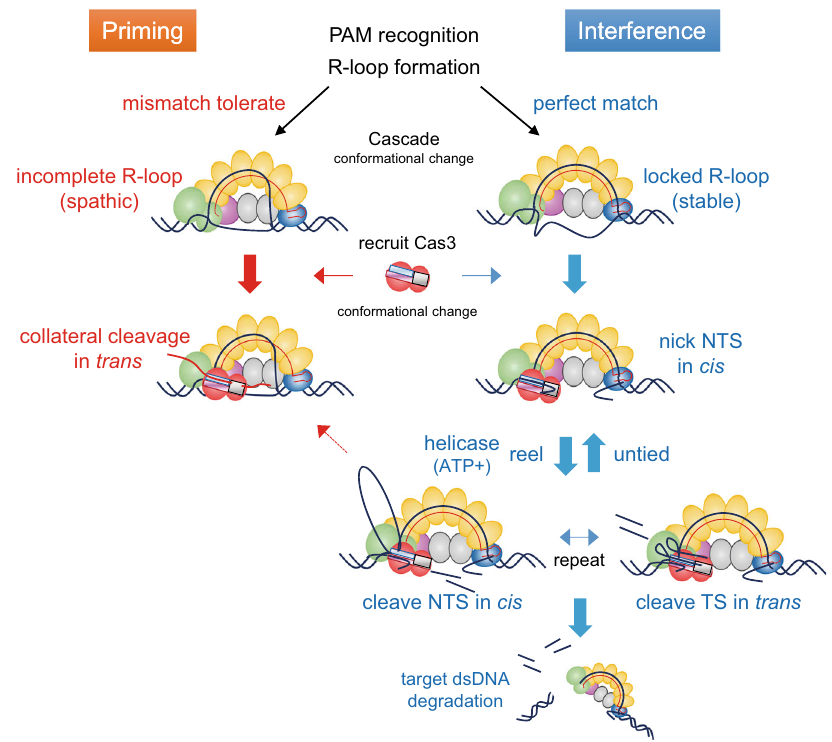
Fig. 6 | Mechanism of type I CRISPRinterference and priming. Cascade binding to target DNA with tolerated mismatches elicits collateral ssDNA cleavage as a priming mode. Stable Cascade binding via a complete R-loop formation drives nicking of the non-targetstrand (NTS), followed by helicase-dependent unwinding